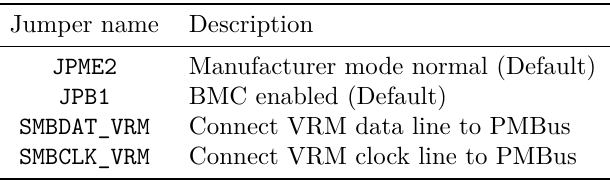
Table 2: Jumper settings on Supermicro